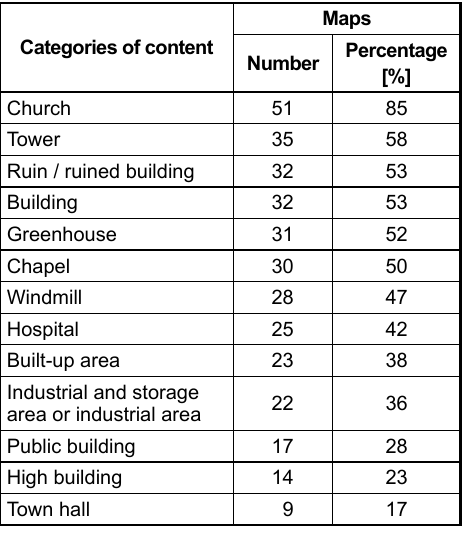
Table 3. The number and percentage of maps with the most commonly recurring categories of build-up areas